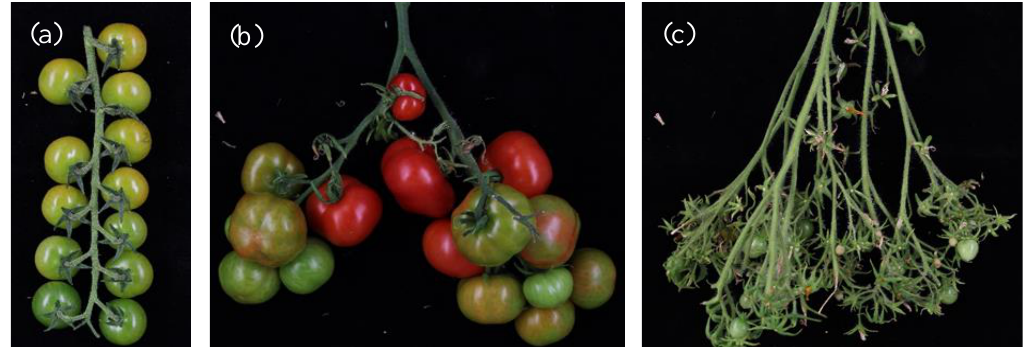
Figure 3. Inflorescence branching categories. ( a ) sSimple or fishbone, ( b ) forked, and ( c ) compound. Based on these three architecture types our genotypes were classified as: 1: simple / fishbone; 2: simple and forked; 3: forked; 4: forked and compound; and, 5: